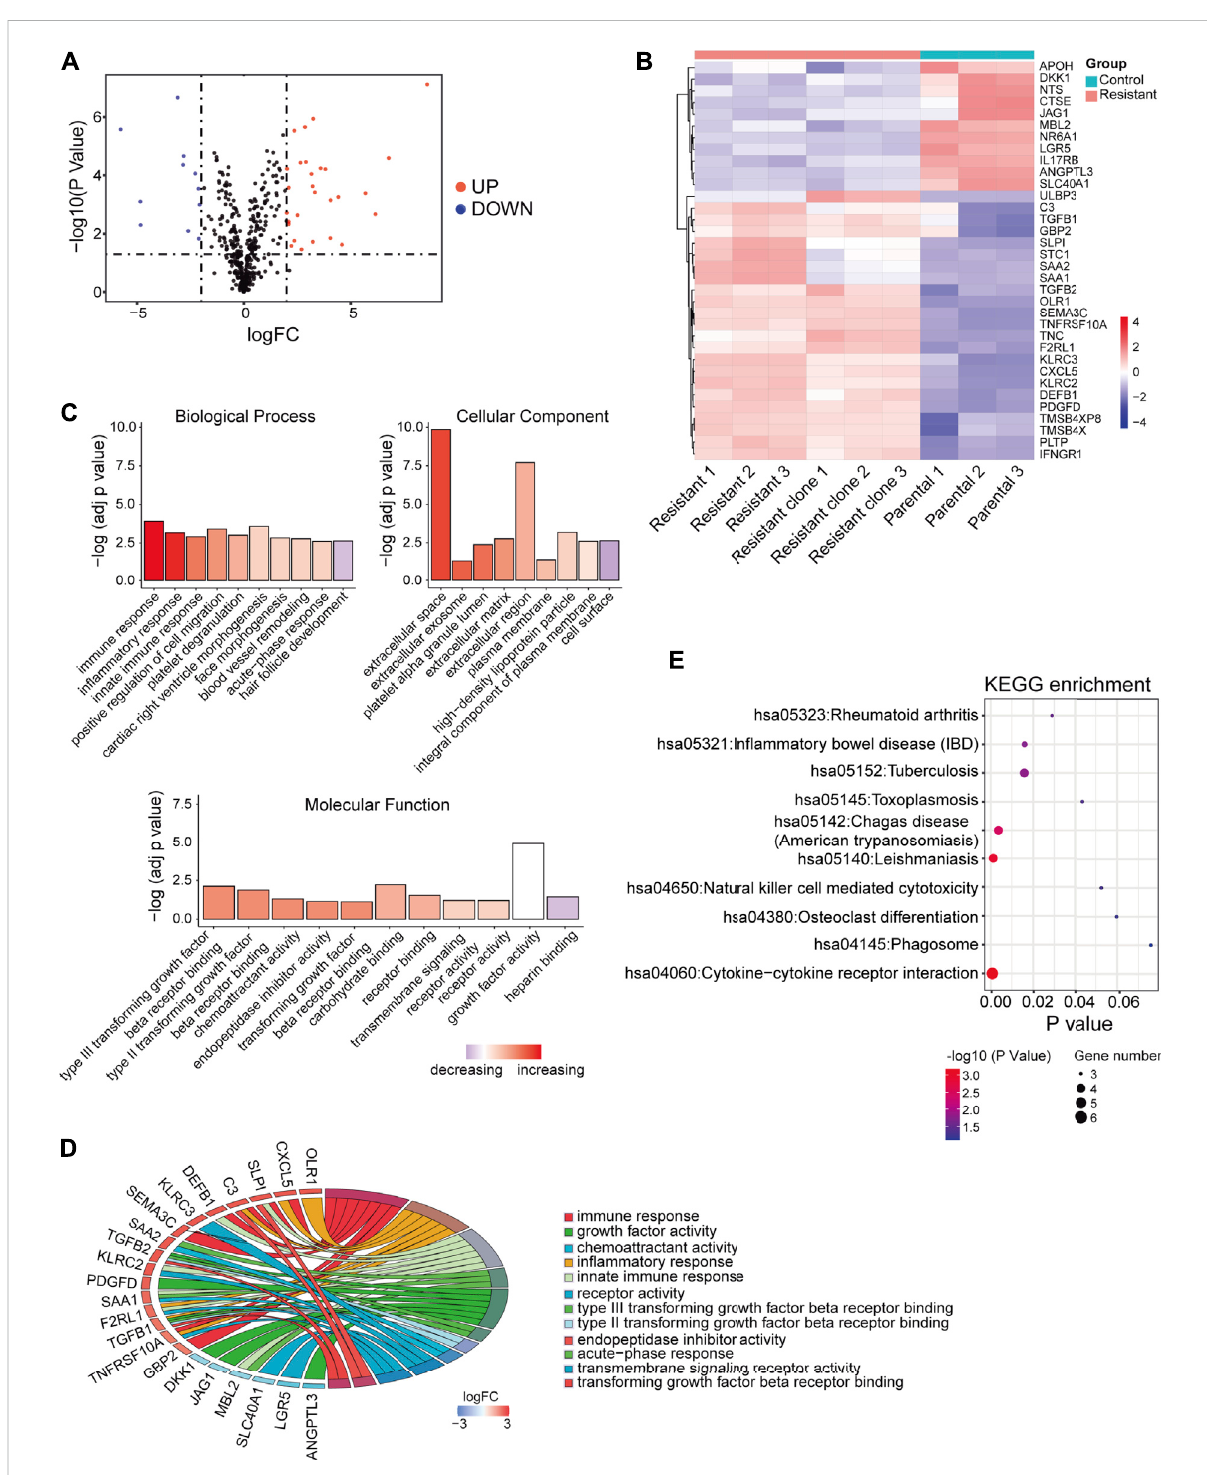
FIGURE 2 DEIRGs between sorafenib-resistant and control cells and functional enrichment analysis. (A) Volcano plot of DEIRGs between sorafenib- resistant and control cells. (B) Hierarchical clustering heat maps of DEIRGs. (C) Bar plot of enriched GO terms in biological process, cell component, and molecular function. (D) GOChord plot indicating the relationship between immune-related GO terms and DEIRGs. The color represents upregulation (red) or downregulation (blue). (E) Dot plot showing the enriched KEGG pathways in DEIRGs.